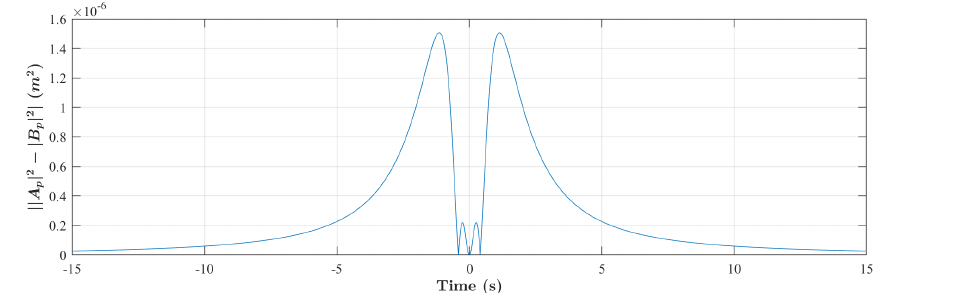
Figure 3. The absolute value of the intensity difference between the time- and space-like Peregrine breather for the carrier wave parameters ak = 0.1 and a = 0.01 m at x = 0 m.